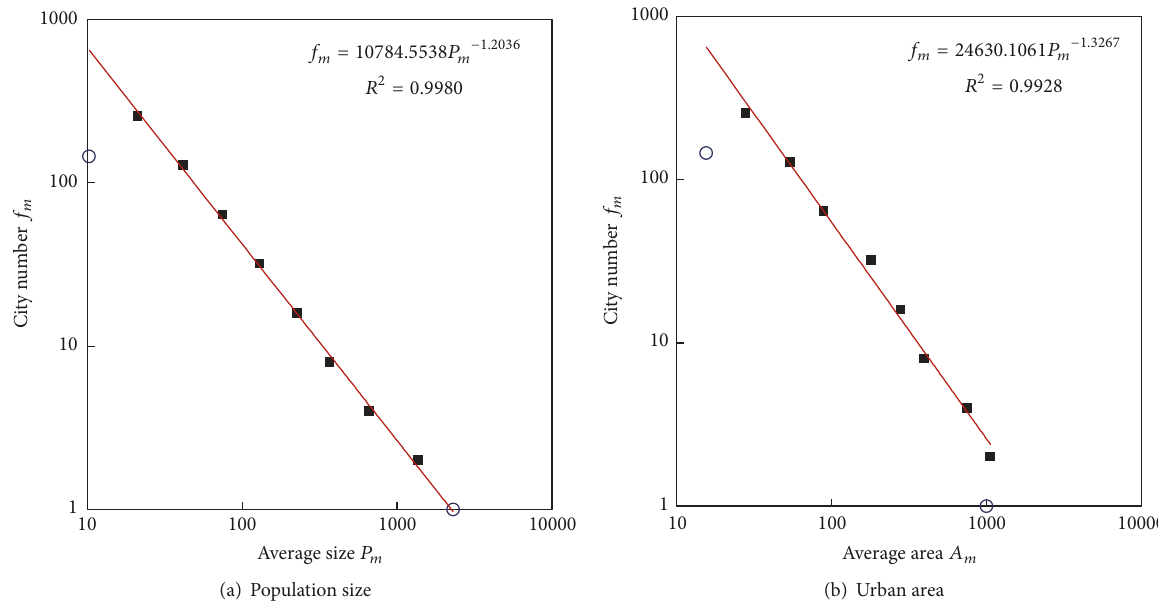
Figure 5: The hierarchical scaling relationships between population size, built-up area, and number of Chinese cities in 2010. [ Note . The small circles represent top classes and the lame-duck classes. The slopes based on the scaling ranges indicate the fractal parameters of city-size and area distributions. The ratio of the size dimension D to the area dimension 𝑑 is an approximate value of the allometric scaling exponent 𝑏